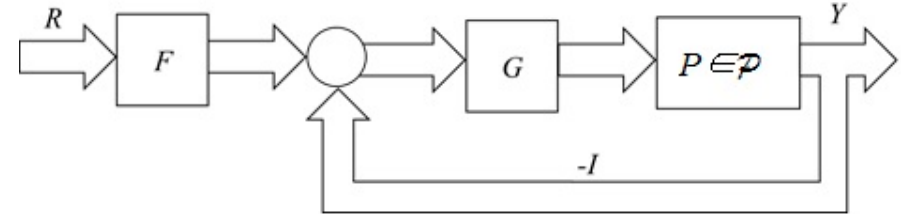
Figure 1. The 2-degree of freedom (DOF) multi-input multi-output (MIMO) control structure in quantitative feedback theory (QFT).